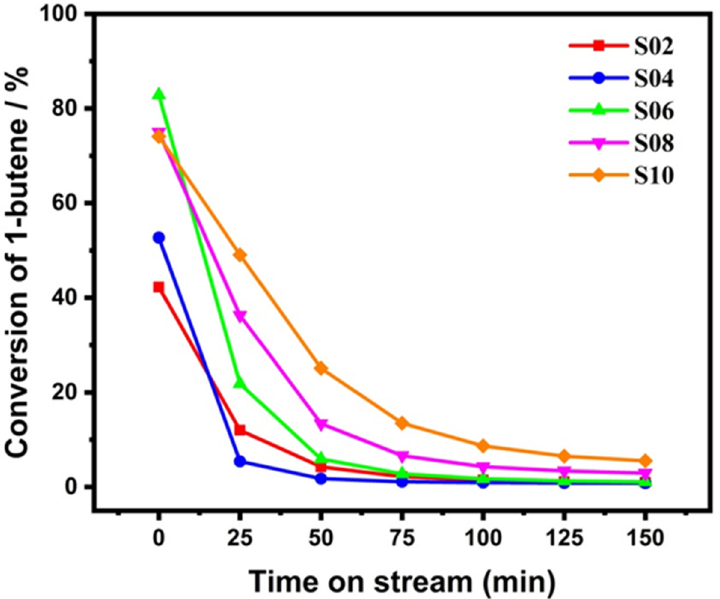
Figure 7. The conversion of 1-butene for SAPO-34 catalysts with time on stream. Reaction condi- WHSV = 1.5 h − 1 , P = 0.1 Mpa, T = 500 ◦ tions ： WHSV = 1.5 h − 1 , P = 0.1 Mpa, T = 500 °C.